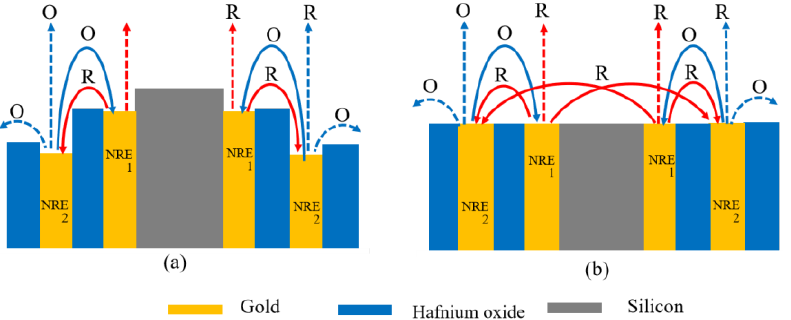
Figure 4. Schematic of analyte diffusion paths. Cross-sectional view of the ( a ) actual geometry of Au NREs, ( b ) designed/expected/theoretical geometry of Au NREs. Legends: Au (yellow), silicon (grey), HfO 2 (blue). “R” represents reduction production and “O” represents oxidation production. Analytes lost due to random diffusion (dashed curve); analytes partaking in RC (solid curve); reduction product (red curve); oxidation product (blue curve).